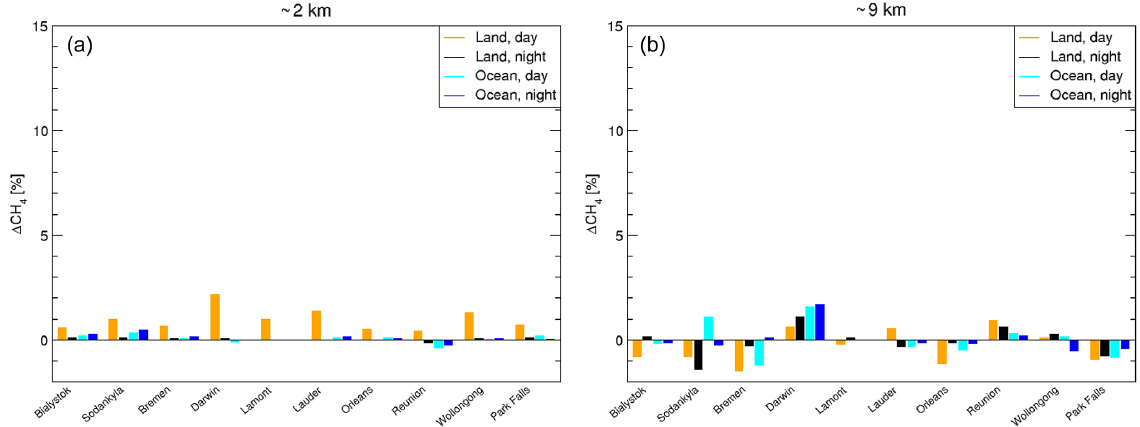
Figure 10. Bar-graphs for the relative deviation in the partial methane column at ≈ 2km altitude (a) and ≈ 9km (b) for ten different TCCON stations. The data are divided for different scenes; land and ocean scenes during daytime (orange and cyan, respectively) and nighttime (black and blue, respectively ).